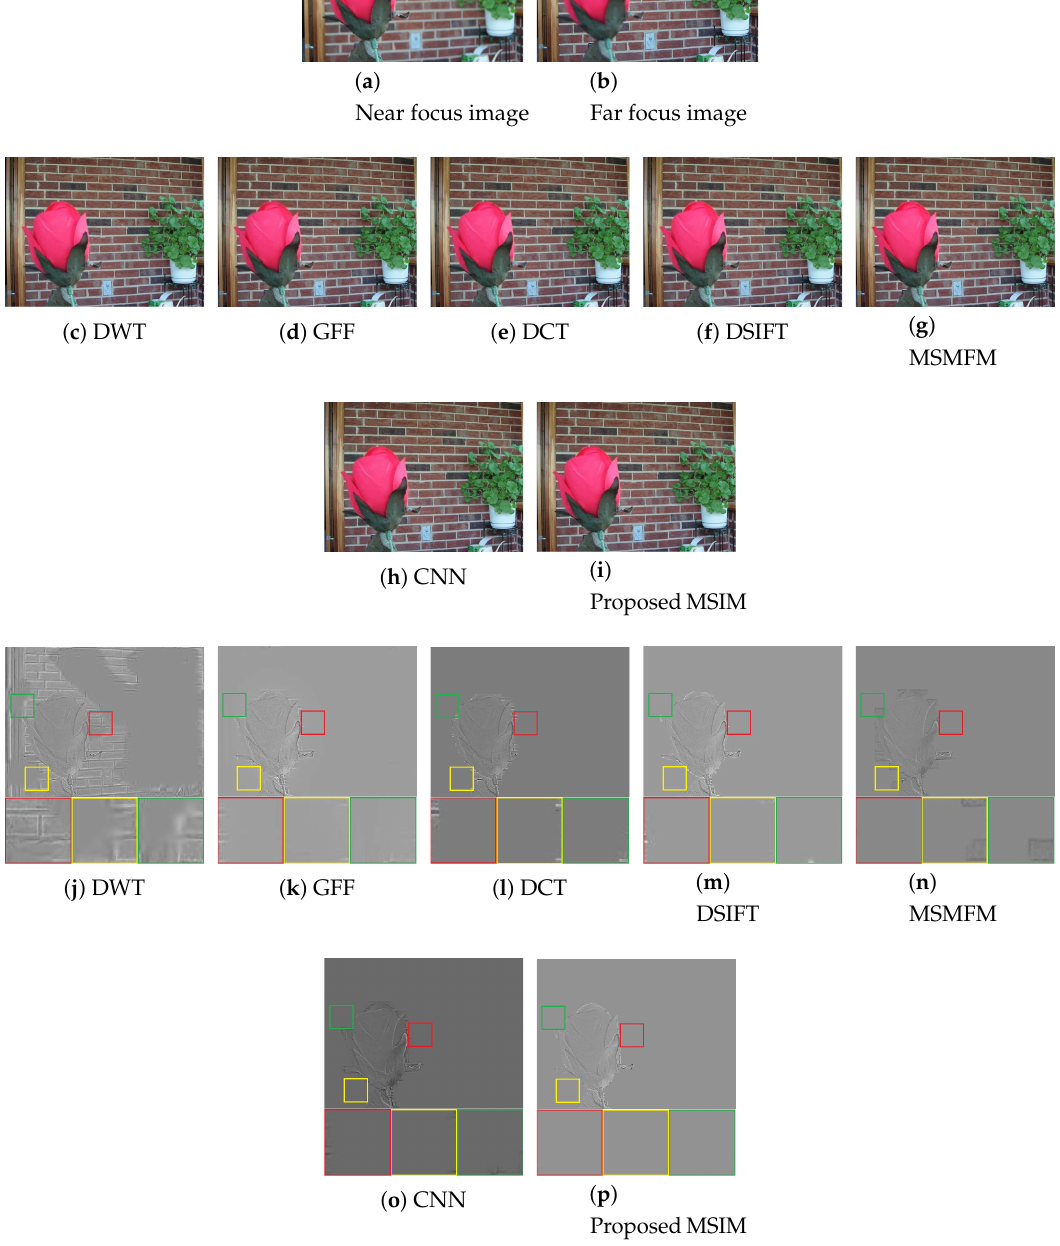
Figure 6. Results of image fusion and their difference images on the “Flower” source images. ( c – i ) Fused images obtained through fusion schemes. ( j – p ) Difference images obtained from the fusion results and Figure